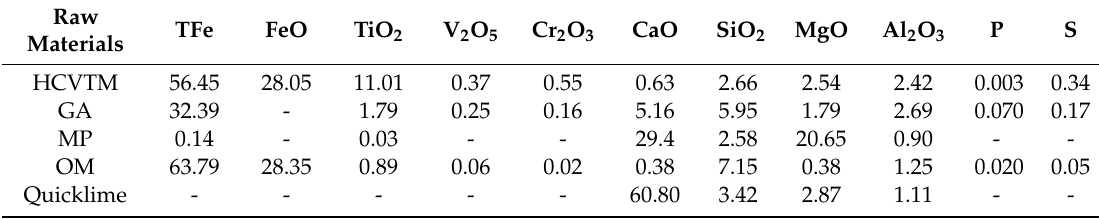
Table 1. The chemical compositions of raw materials